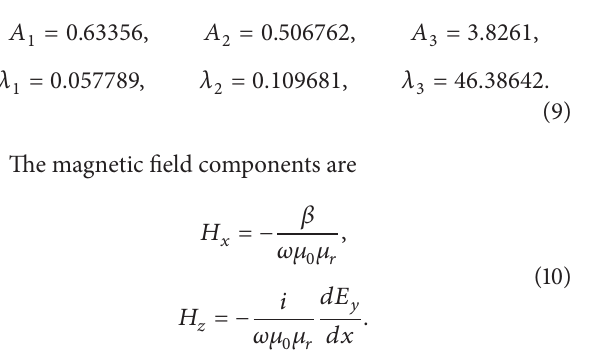
Figure 2: Geometrical structure of the slab waveguide. The upper and lower layers (cladding and substrate) are made from Terahertz left-handed metamaterial, and the core is dielectric material (BaF 2